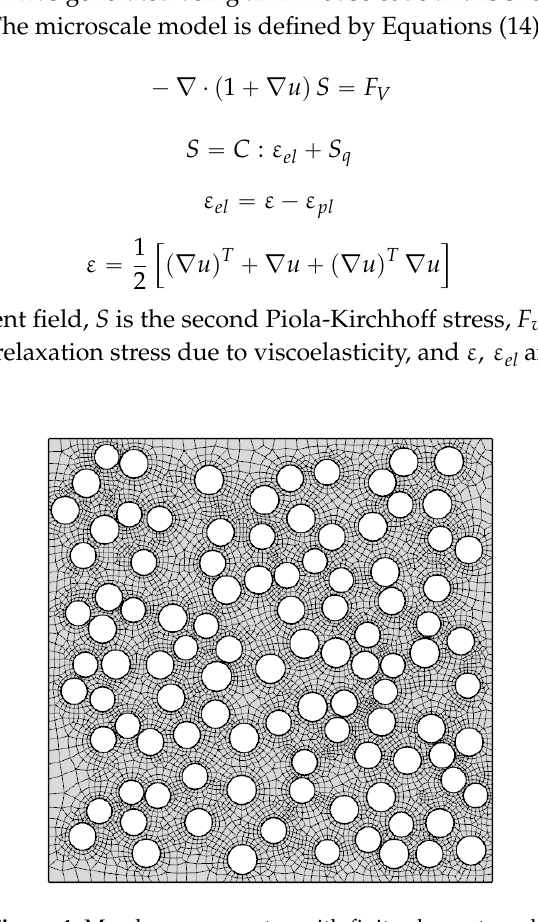
Figure 4. Membrane geometry with finite element mesh.